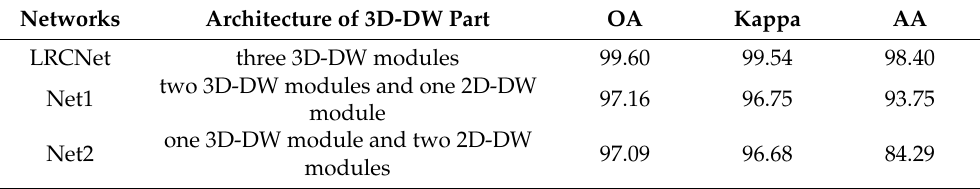
Table 5. The classification accuracy obtained using a small number of training samples (%).